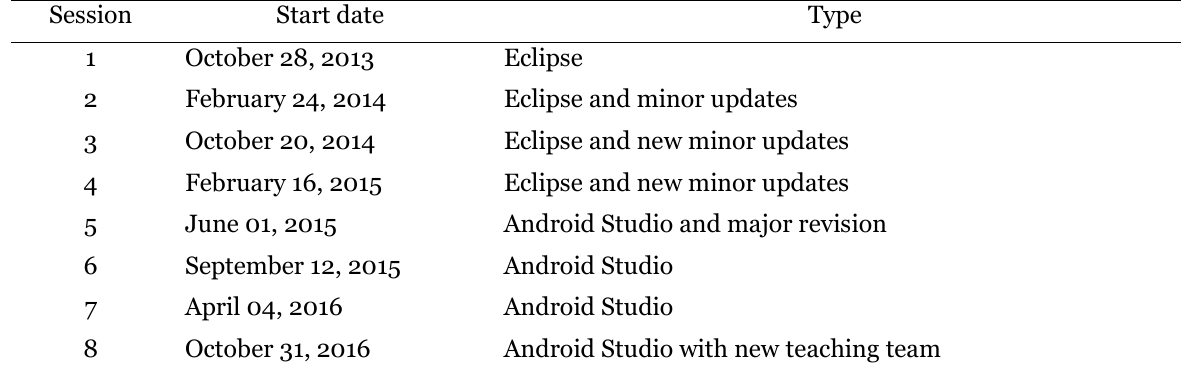
Table 2 Different Sessions of the